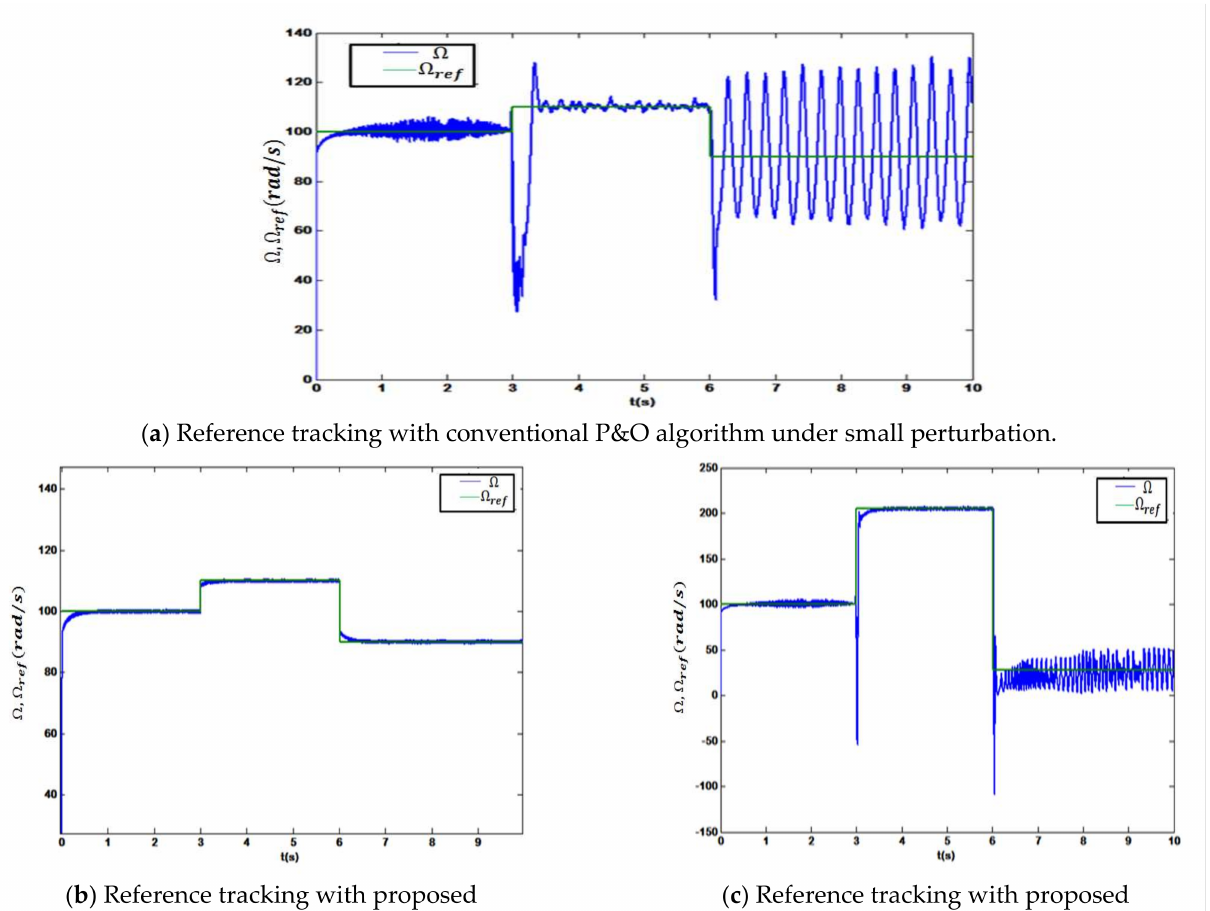
Figure 16. Comparison of Performances of PV system between MPPT with P&O and the proposed algorithms (algorithm under tolerable perturbation. algorithm under higher